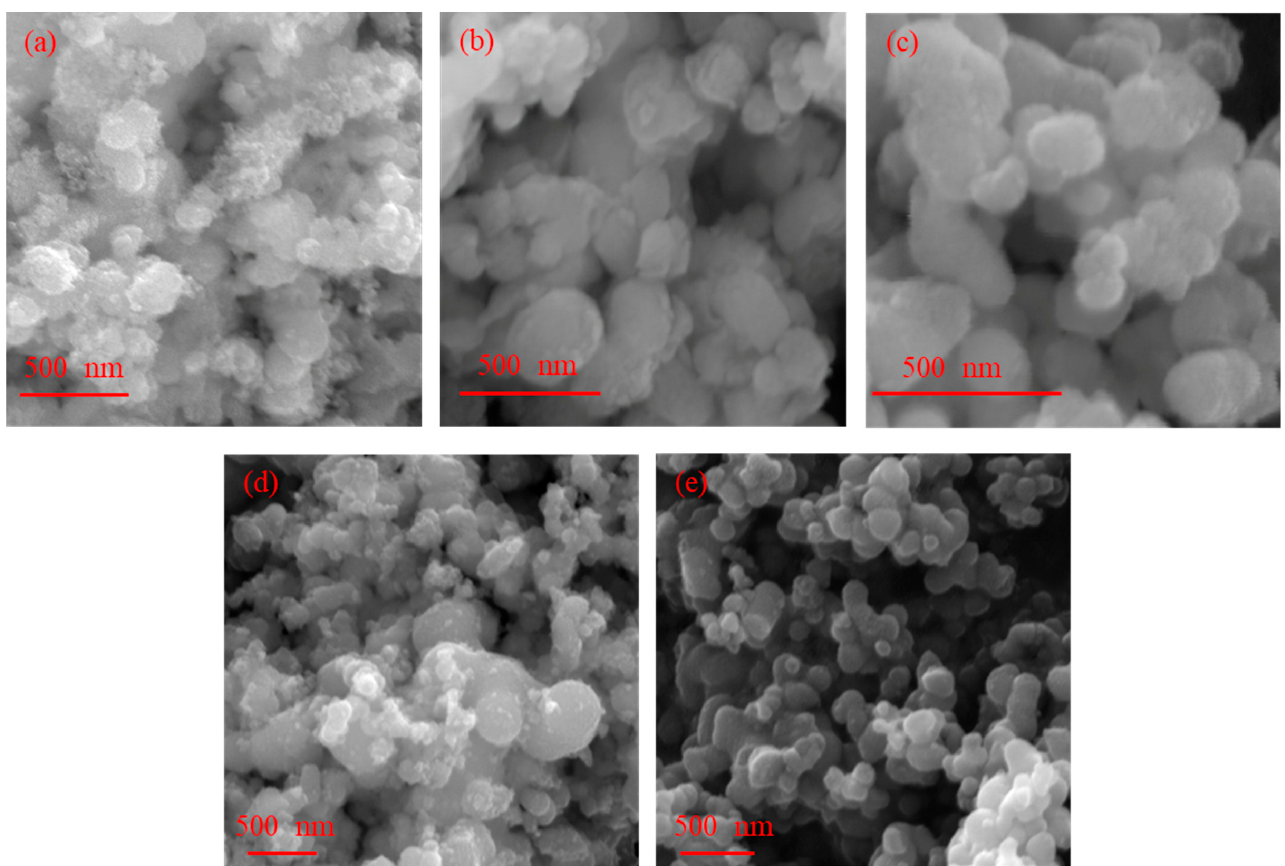
Figure 1. Scanning electron microscopy images: ( a ) TiO 2 ; ( b ) Co/TiO 2 ; ( c ) Cu/TiO 2 ; ( d ) Fe/TiO 2 ; and ( e ) Ni/TiO 2 .